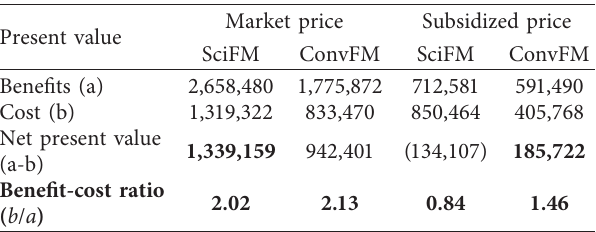
Table 7: Financial analysis of two forest management system.